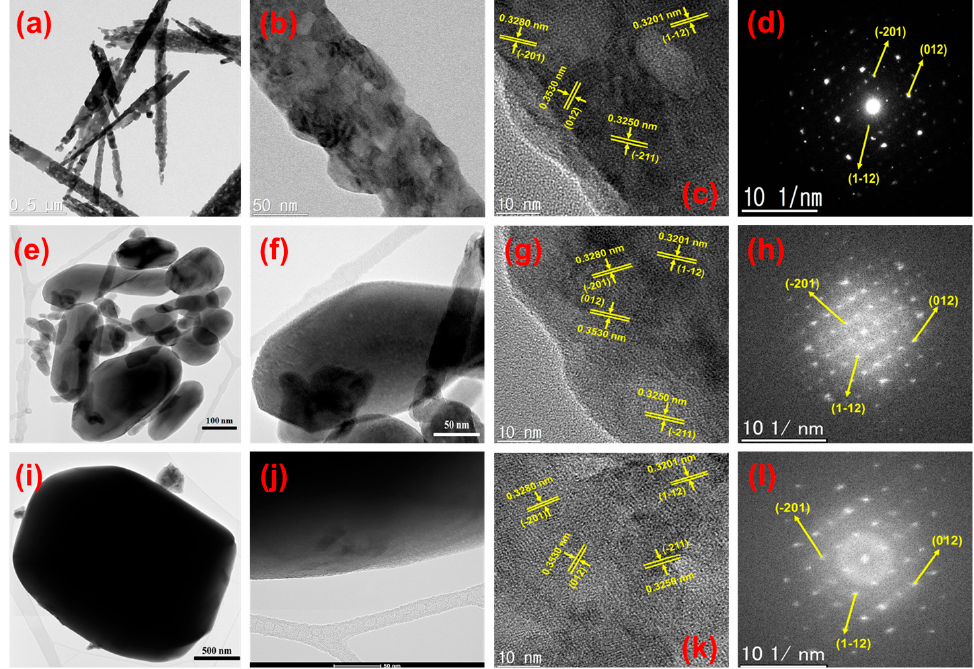
Figure 4. TEM images of ( a , b ) FV500, ( e , f ) FV600, and ( i , j ) FV700 and HRTEM images of ( c ) FV500, ( g ) FV600, and ( k ) FV700, respectively. SAED patterns of ( d ) FV500, ( h ) FV600, and ( l ) FV700, respectively.